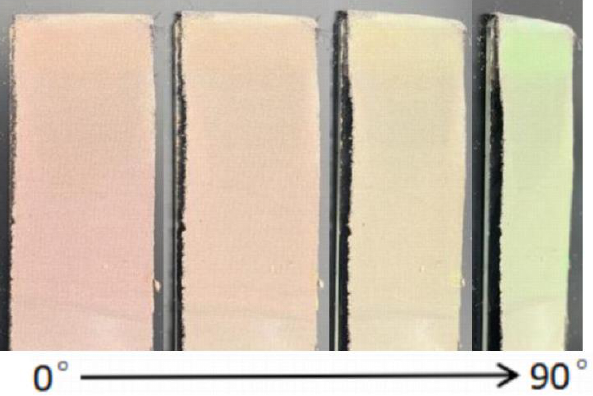
Figure 6. Photographs of various structural colors on silk fabricated by the colloidal microspheres with the same diameter of 330 nm at different viewing angles from 0° to 90°.